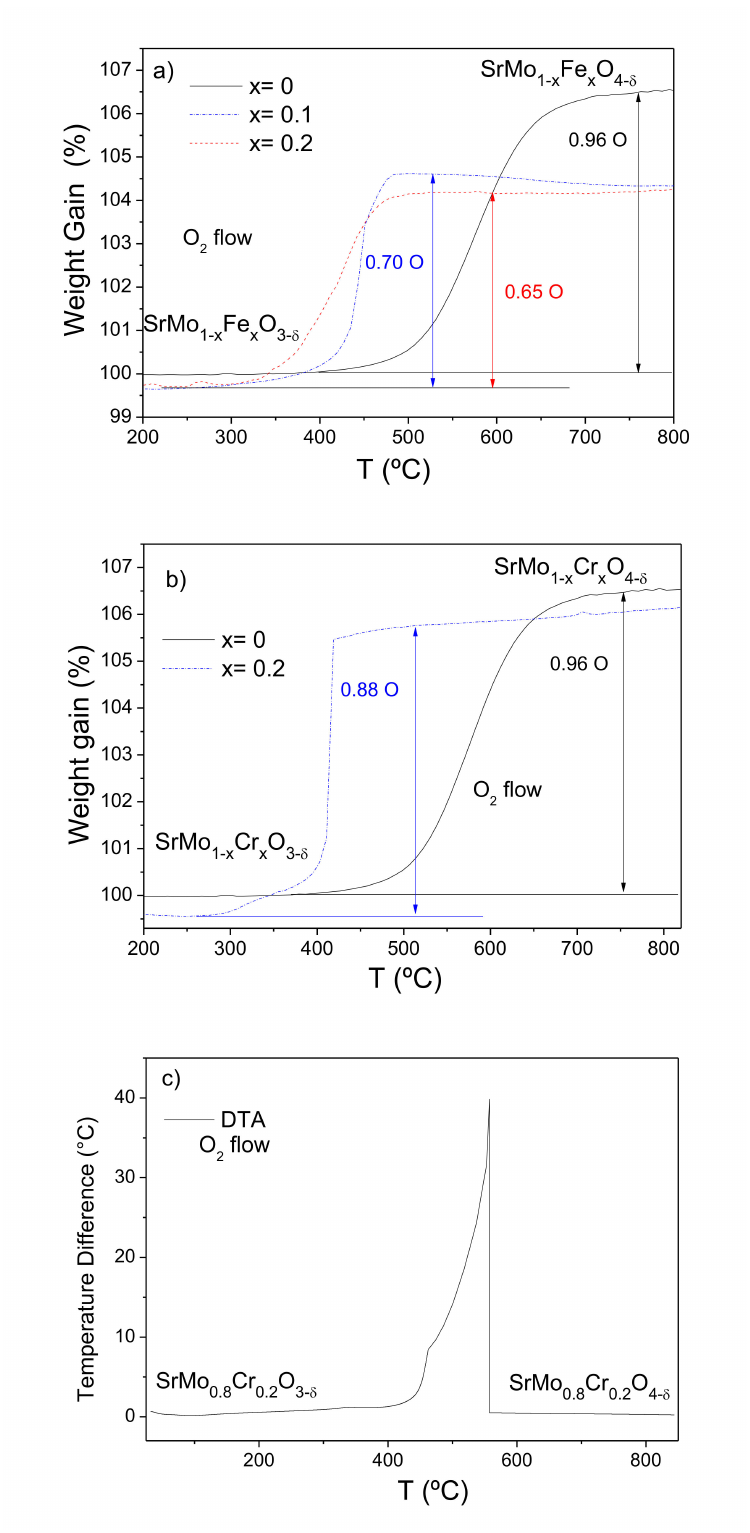
Figure 4. Thermal analysis in O 2 flow (TG curve) of ( a ) SrMo 1 − x Fe x O 3 − δ , ( b ) SrMo 1 − x Cr x O 3 − δ perovskites, showing an oxidation step of the oxygen-deficient SrMo 1 − x M x O 4 − δ scheelite phase and ( c ) differential thermal analysis (DTA) of SrMo 0.8 Cr 0.2 O 3 − δ